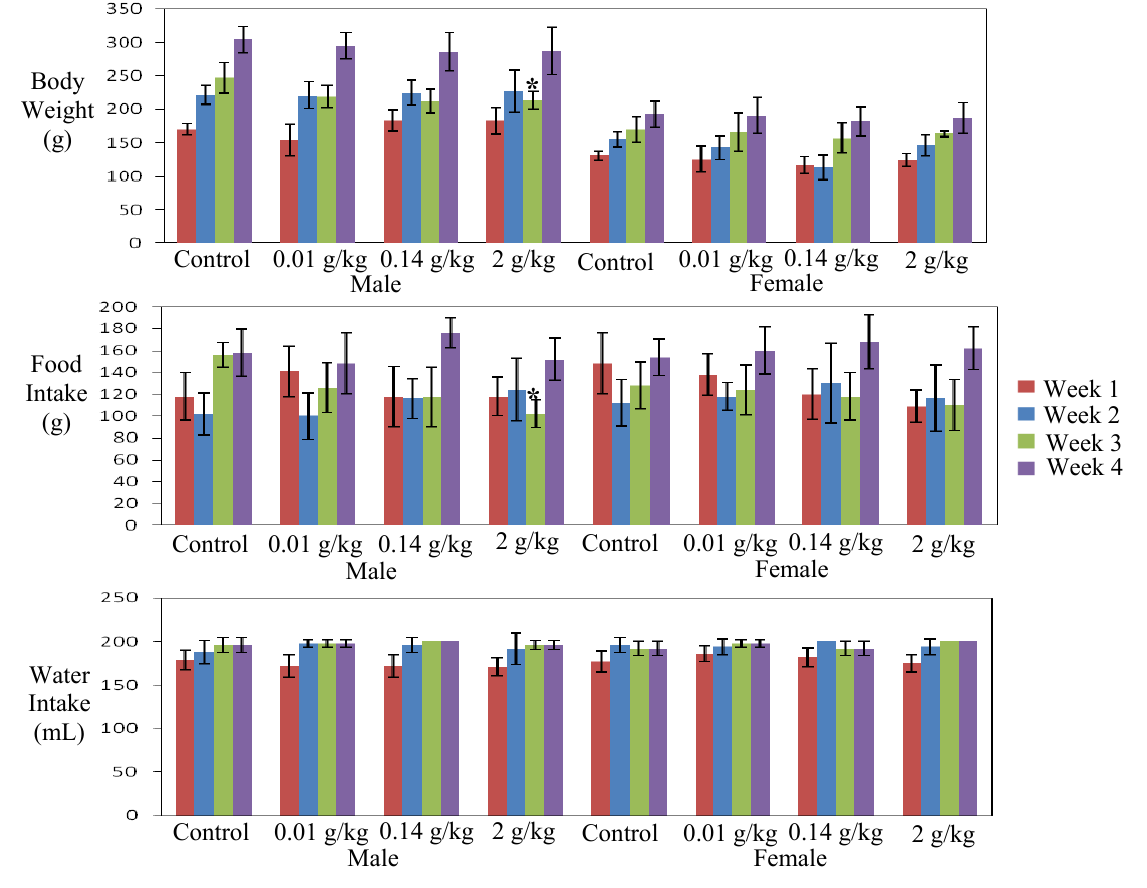
Figure 2. Effect of sub acute administration of C. papaya extract for 28 days on body weight, food intake and water intake of male and female rats. Data are expressed as mean ± standard deviation. * Significant value ( p <